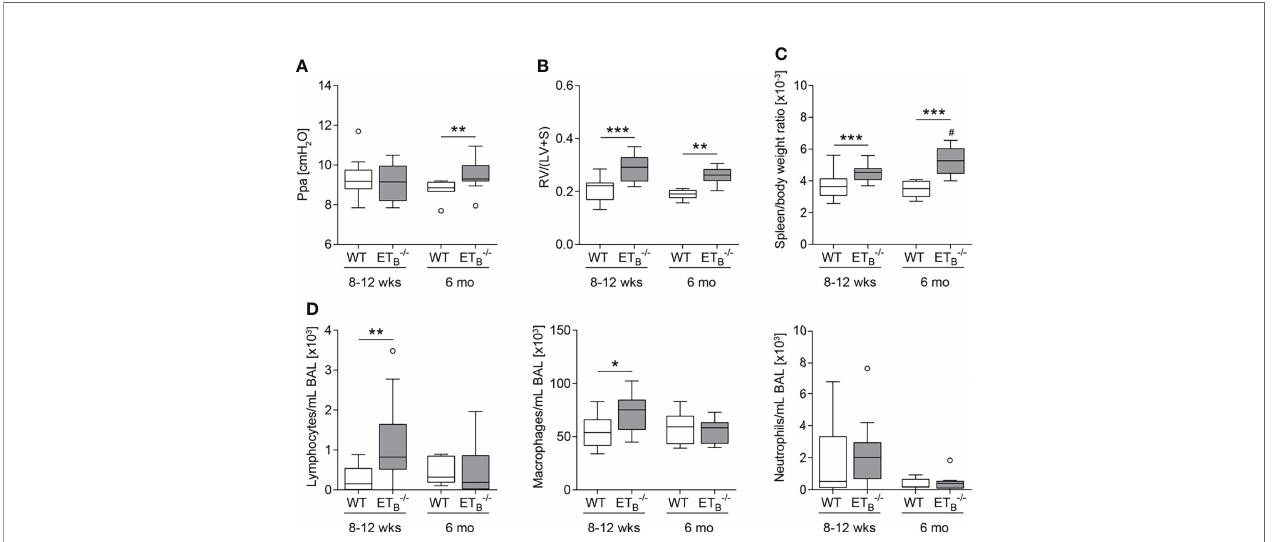
FIGURE 3 | ET B de fi ciency was age-dependently associated with increased pulmonary arterial pressure, right ventricular hypertrophy, splenomegaly, and increased number of lymphocytes in bronchoalveolar lavage. Lungs, hearts, and spleens of 8- to 12-week (wk)-old and 6-mo-old rescued endothelin B receptor-de fi cient (ET B-/- ) and corresponding wild-type (WT) mice were removed, or bronchoalveolar lavage (BAL) was performed. (A) In isolated perfused and ventilated lungs, under basal conditions, pulmonary arterial pressure (Ppa) was increased in 6-mo-old ET B-/- compared to WT mice of the same age. (B) Fulton index [ratio of right ventricle (RV) and left ventricle (LV) including septum (S)] determined after weighing the cardiac compartments was higher in ET B-/- compared to WT mice. (C) Determination of spleen weight related to body weight revealed splenomegaly in ET B-/- mice. (D) Analysis of differentially quanti fi ed leukocytes in BAL revealed increased number of lymphocytes and macrophages in BAL from 8- to 12-wk-old ET B-/- vs. WT mice of the same age. Data are represented as box plots depicting median, quartiles, and ranges excluding outliers ( open circles ). In (A – C) , N = 7 – 28; in (D) , N = 7 – 17. # indicates signi fi cant difference in the 6-mo-old vs. the corresponding 8- to 12-wk-old group, * indicates signi fi cant difference between ET B-/- vs. the corresponding WT group. * /# p < 0.05, ** p < 0.01, *** p < 0.001 (Mann – Whitney U test).